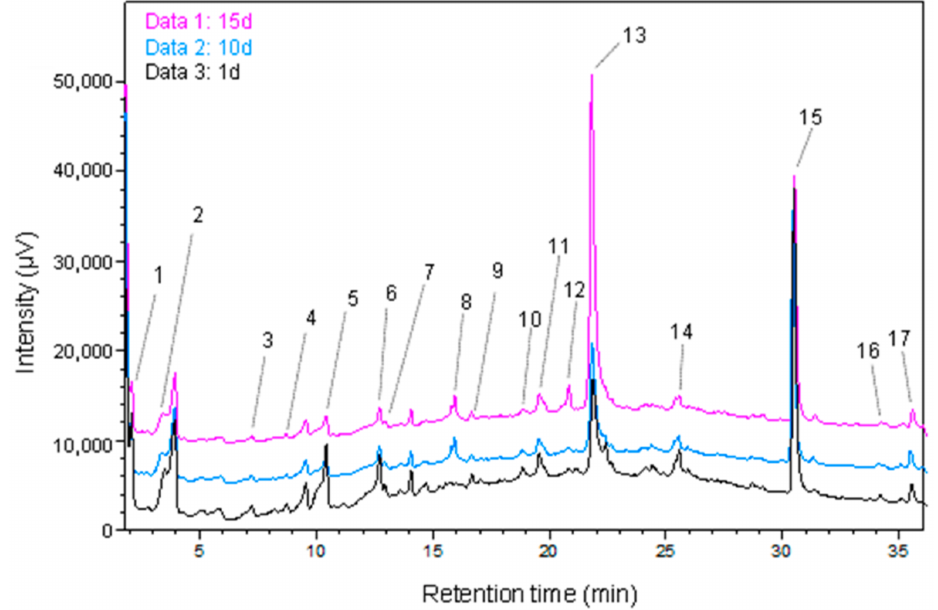
Figure 1. UHPLC chromatograms of phenolic compounds in GP extracts after 1, 10 and 15 days of SSF with CS: (1) gallic acid, (2) 3.4-dihydroxybenzoic acid, (3) p -hydroxybenzoic acid, (4) procyanidin B1, (5) vanillic acid, (6) syringic acid, (7) procyanidin B2, (8) p -coumaric acid, (9) gallocatechin gallate, (10) ferulic acid, (11) epicatechin gallate, (12) o -coumaric acid, (13) ellagic acid, (14) resveratrol, (15) quercetin, (16) ε -viniferin, (17)